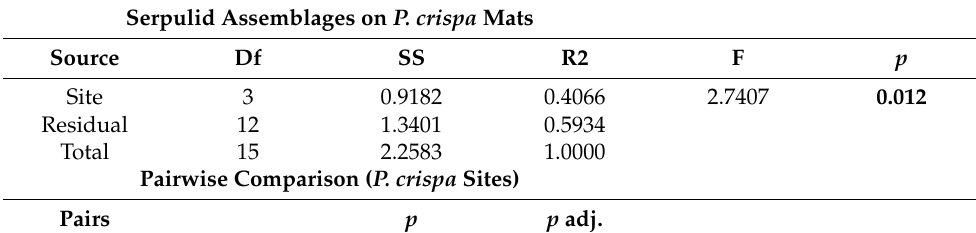
Table 2. Results of permutational multivariate analysis of variance (PERMANOVA) and pairwise comparison of Serpulid assemblages among P. crispa sites. Significant results are indicated in bold.